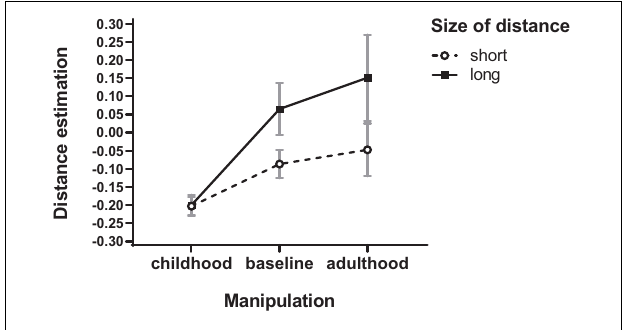
FIGURE 3 | Effects of childhood priming on distance assessment with baseline condition. Error bars represent standard errors of the means.